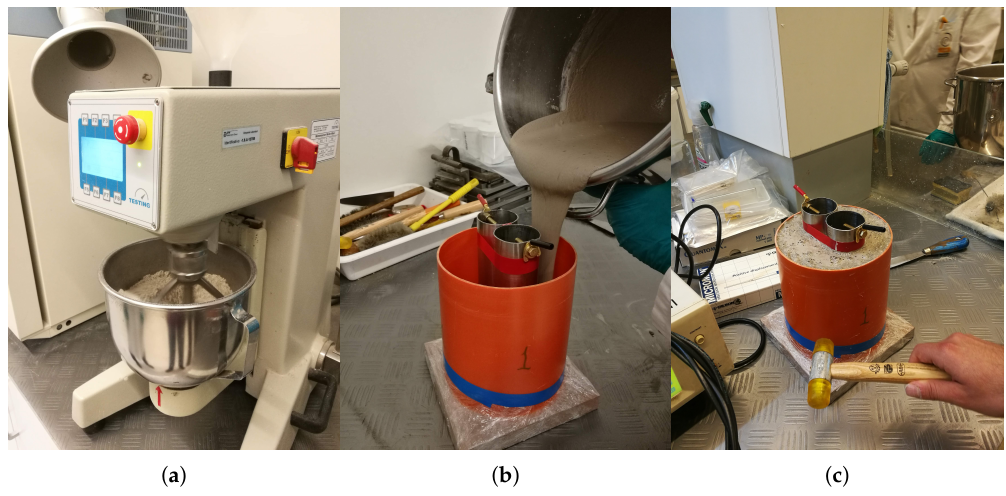
Figure 7. Preparation of the device for the measurement of electric parameters (resistivity and permittivity). Kneading of the concrete components ( a ); filling of the container with the measurement electrodes ( b ); hammering to facilitate the air expulsion and the homogenization of the concrete inside the container ( c